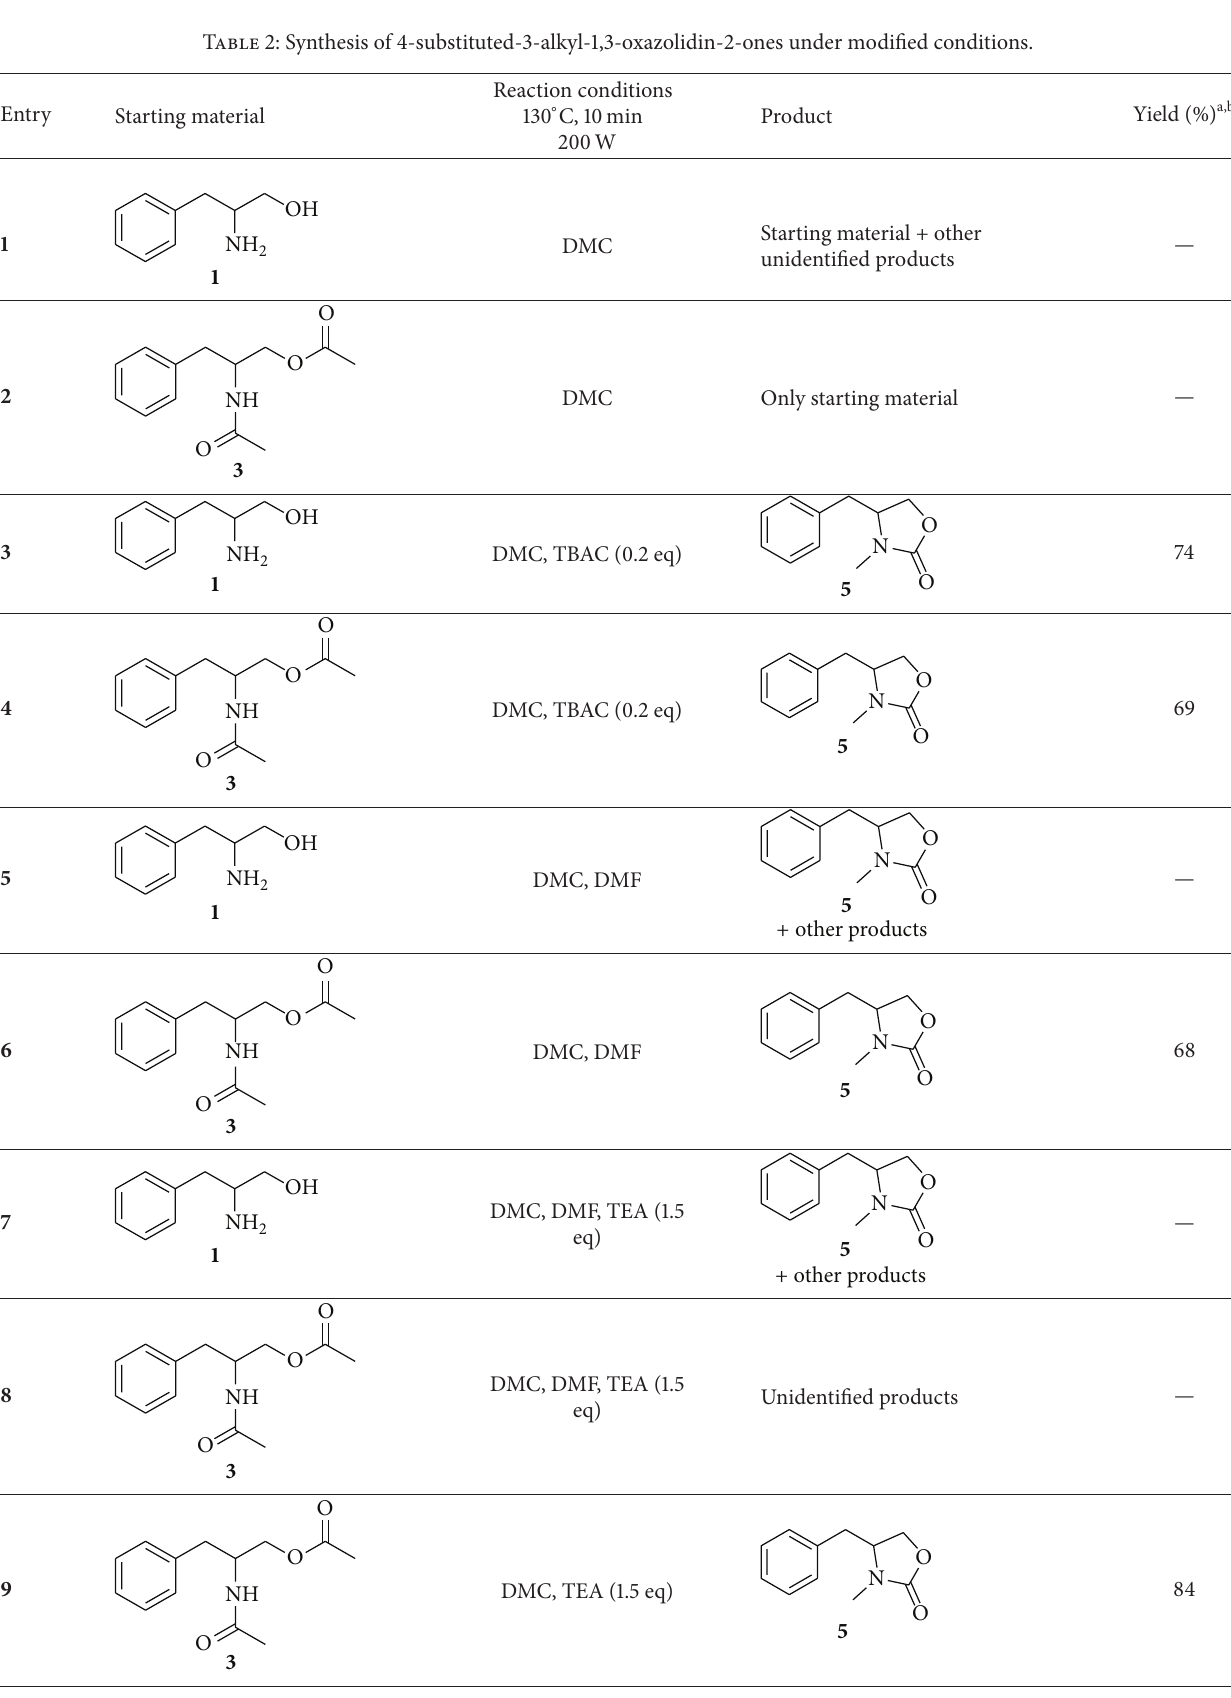
Table 2: Synthesis of 4-substituted-3-alkyl-1,3-oxazolidin-2-ones under modified